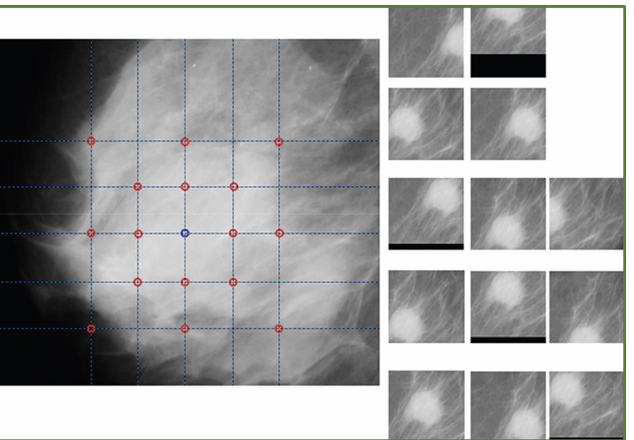
Figure 5. An example of patch of Mammogram and a sample of patches generated with geometric transformation